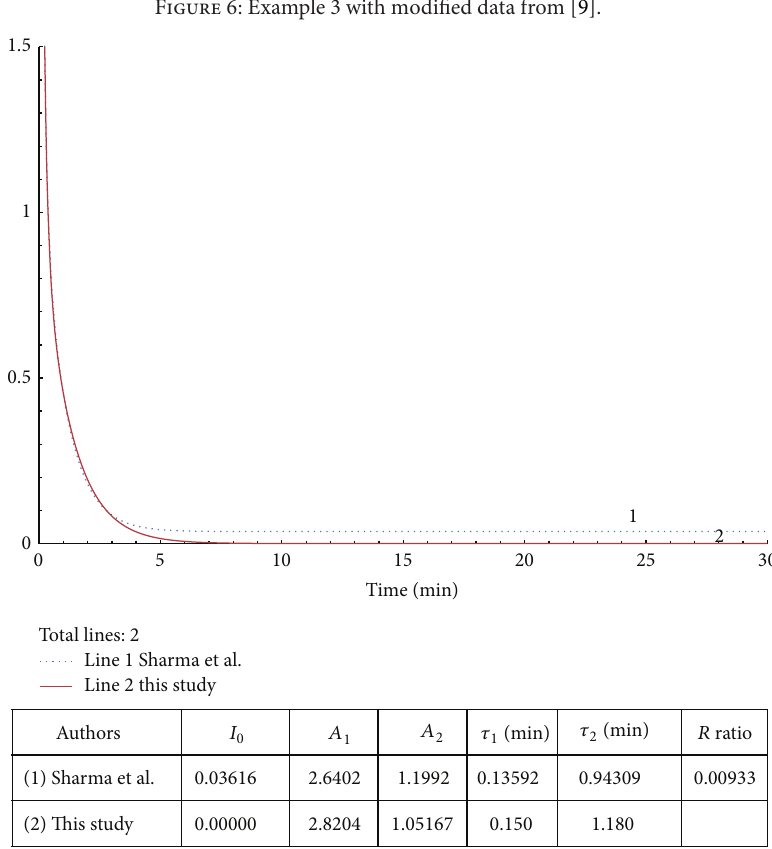
Figure 6: Example 3 with modified data from [9].